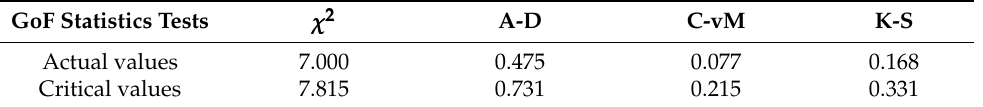
Table 6. Goodness-of-fit statistics tests results for the specimens of 6 mm in diameter.